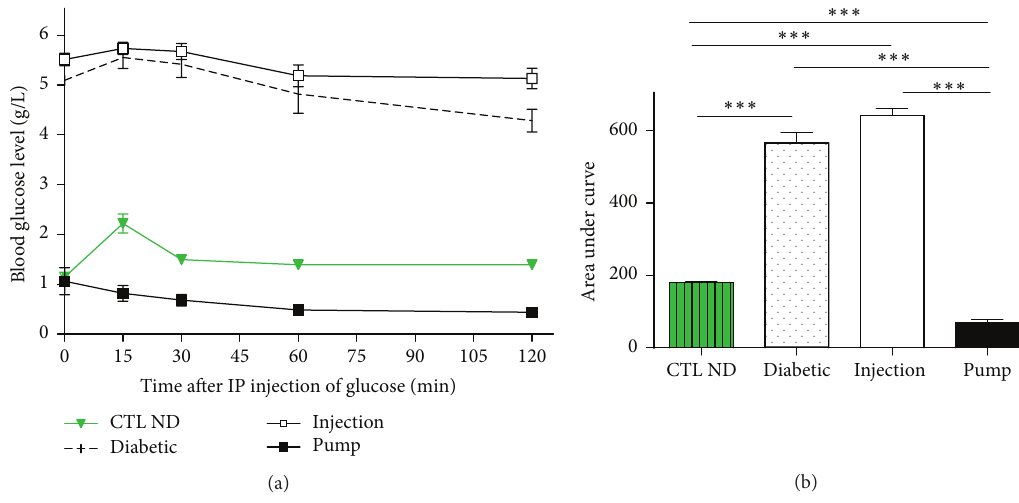
Figure 5: Intraperitoneal glucose tolerance test on rats. IpGTT profile (a) and areas under the curves (b). In control nondiabetic (CTL ND) rats, a rapid elevation of blood glucose (within 15 min) was observed, but with a rapid return to basal level. Diabetic and injection rats had similar profiles, with the glucose levels being much higher than the basal level and remaining high for more than 30min. For the pump rats, glycaemia was observed only after glucose infusion. IP glucose, intraperitoneal glucose injection; IpGTT, intraperitoneal glucose tolerance test. ∗∗∗ 𝑝 < 0.01 .